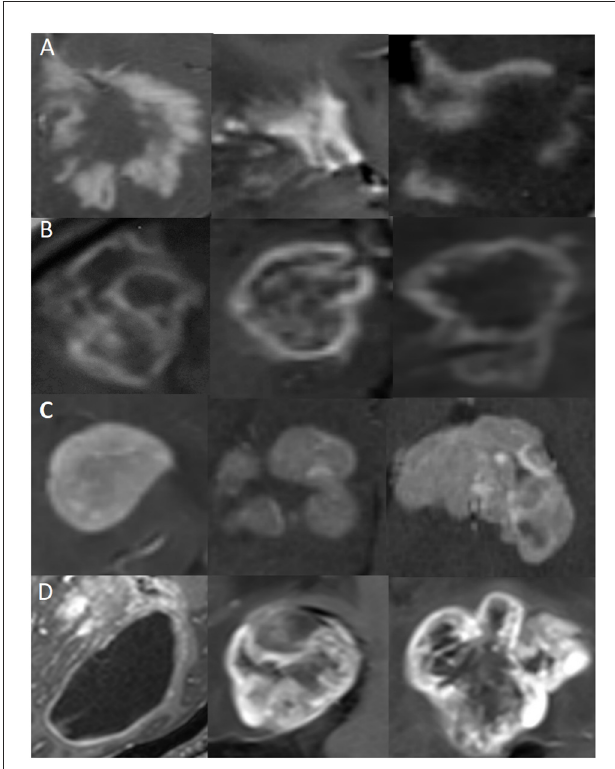
FIGURE1 Representative MR images of clipped regions of interest (ROIs) for the four types of diseases. Each row represents a distinct disease, and each image is from a different patient. (A) ROIs from TDLs. (B) ROIs from TPACNS. (C) ROIs from PCNSL. (D) ROIs from